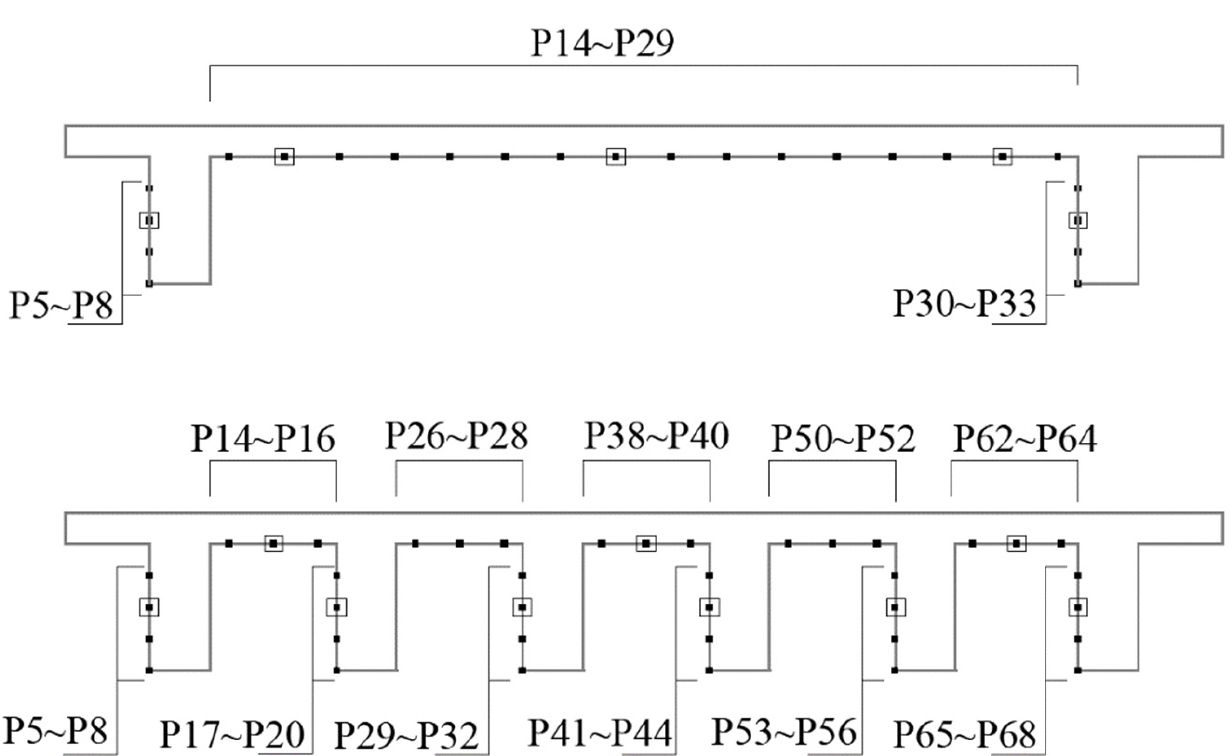
Figure 12. Locations of numerical pressure sensors on the girders and chambers: a. two-girder deck; b. 6-girder deck.